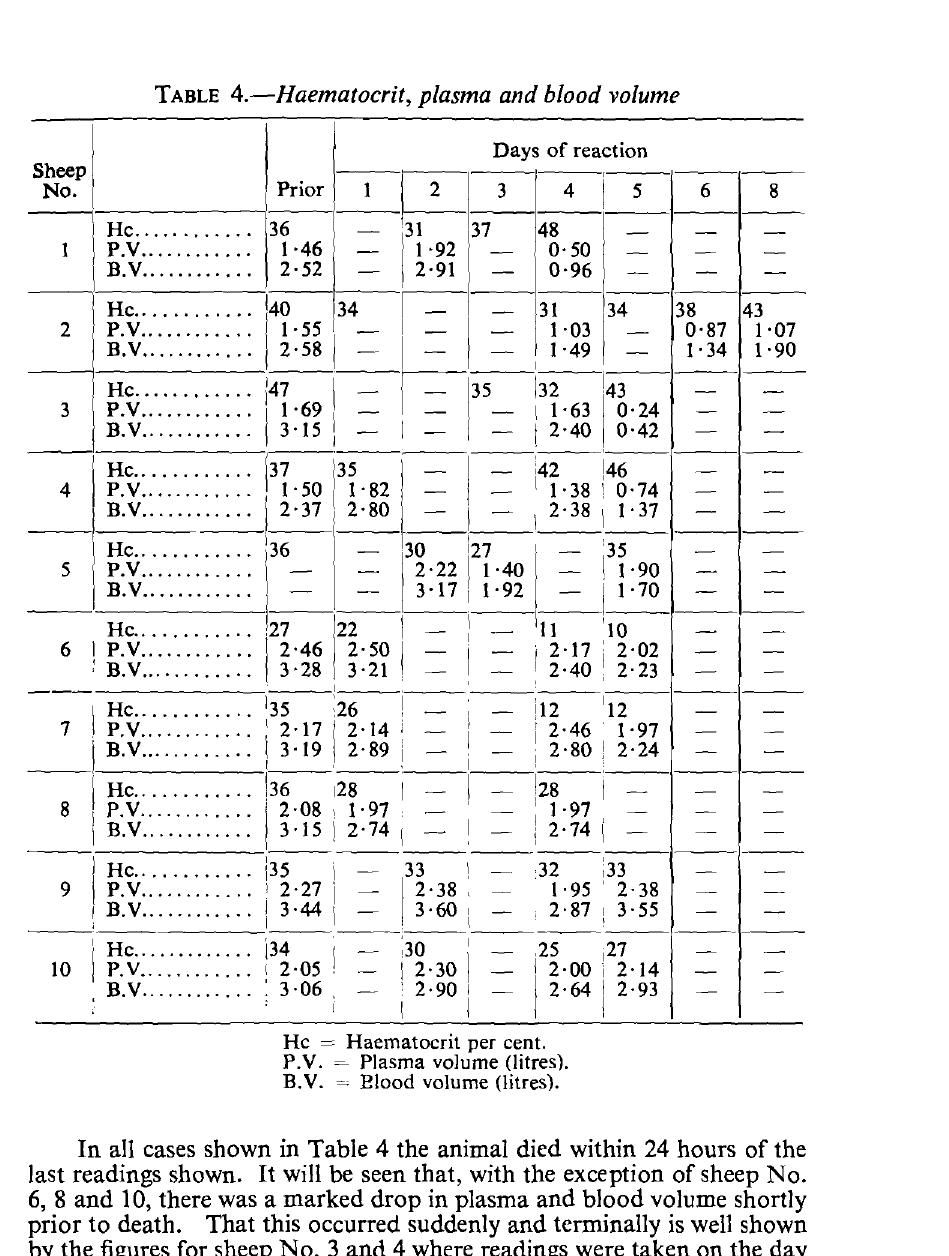
TABLE 4.-Haematocrit, plasma and blood volume I Days of reaction S~~.p